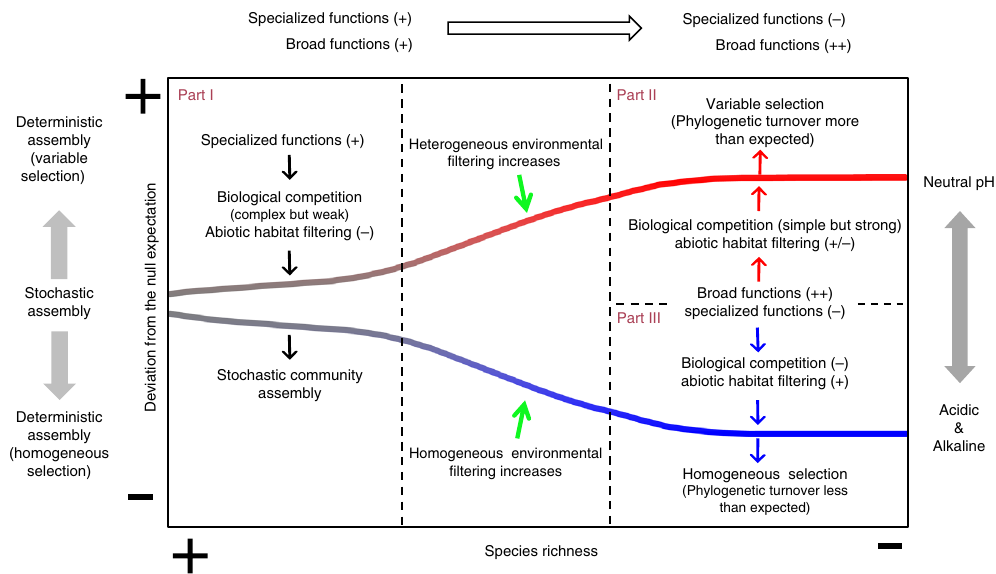
Fig. 5 Conceptual model of bacterial community assembly processes. This conceptual model shows how diversity-related stochastic/deterministic processes contribute to the structural and functional assembly of soil bacterial communities under various pH